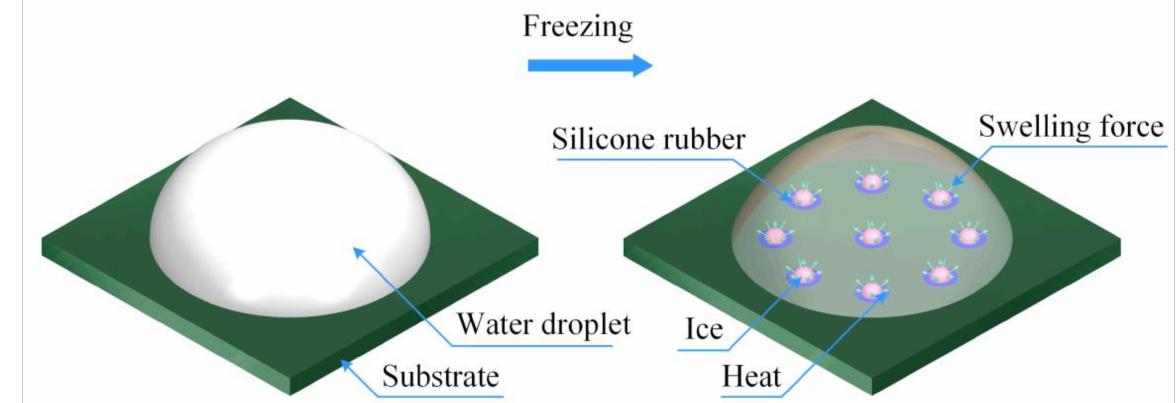
Figure 4. Schematic of the proposed de-icing